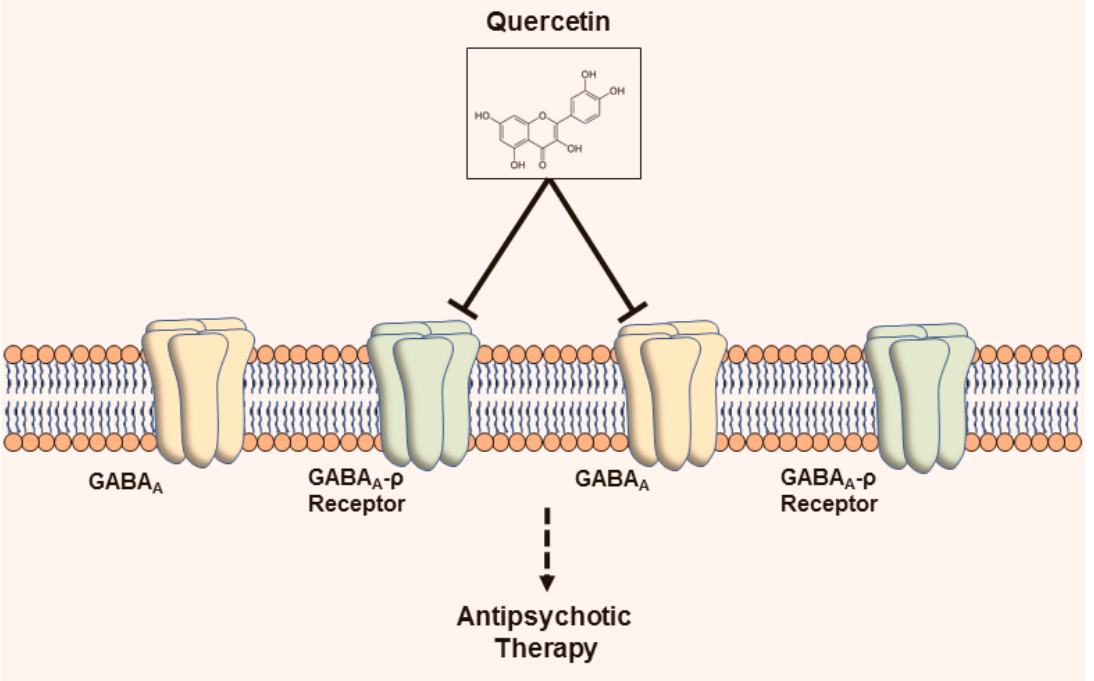
Figure 2. Antipsychotic activity of QC through GABA receptors. QC acts on the GABAA receptor and is possibly suitable for antipsychotic therapy.